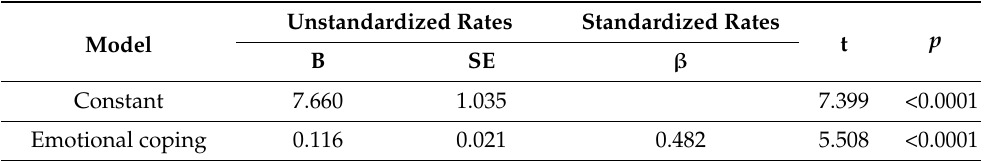
Table 4. Analysis of the backward stepwise regression in pregnant women with gestational diabetes ( n =